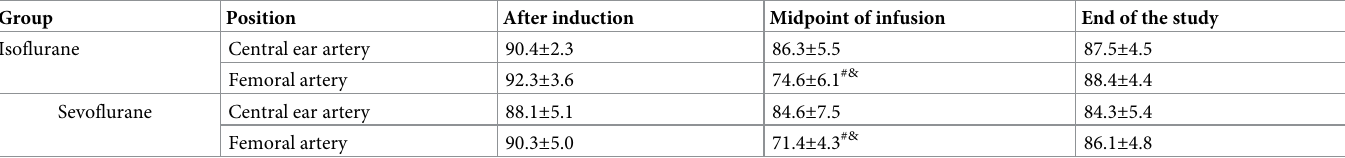
Table 2. The mean atrial pressure (MAP, mmHg) of femoral and central ear artery among different time points in two groups (mean ± SD). Group